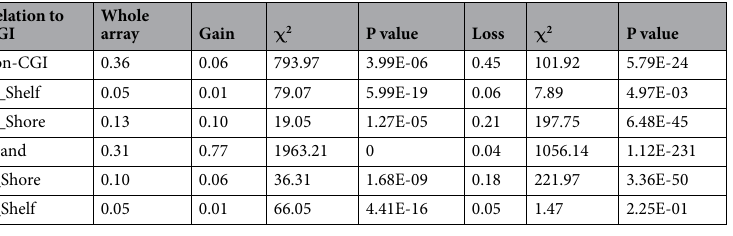
Table 3. Proportionality of locations to CGI for all CpGs of the array and in age-methylated (gain) and demethylated (loss) CpGs.